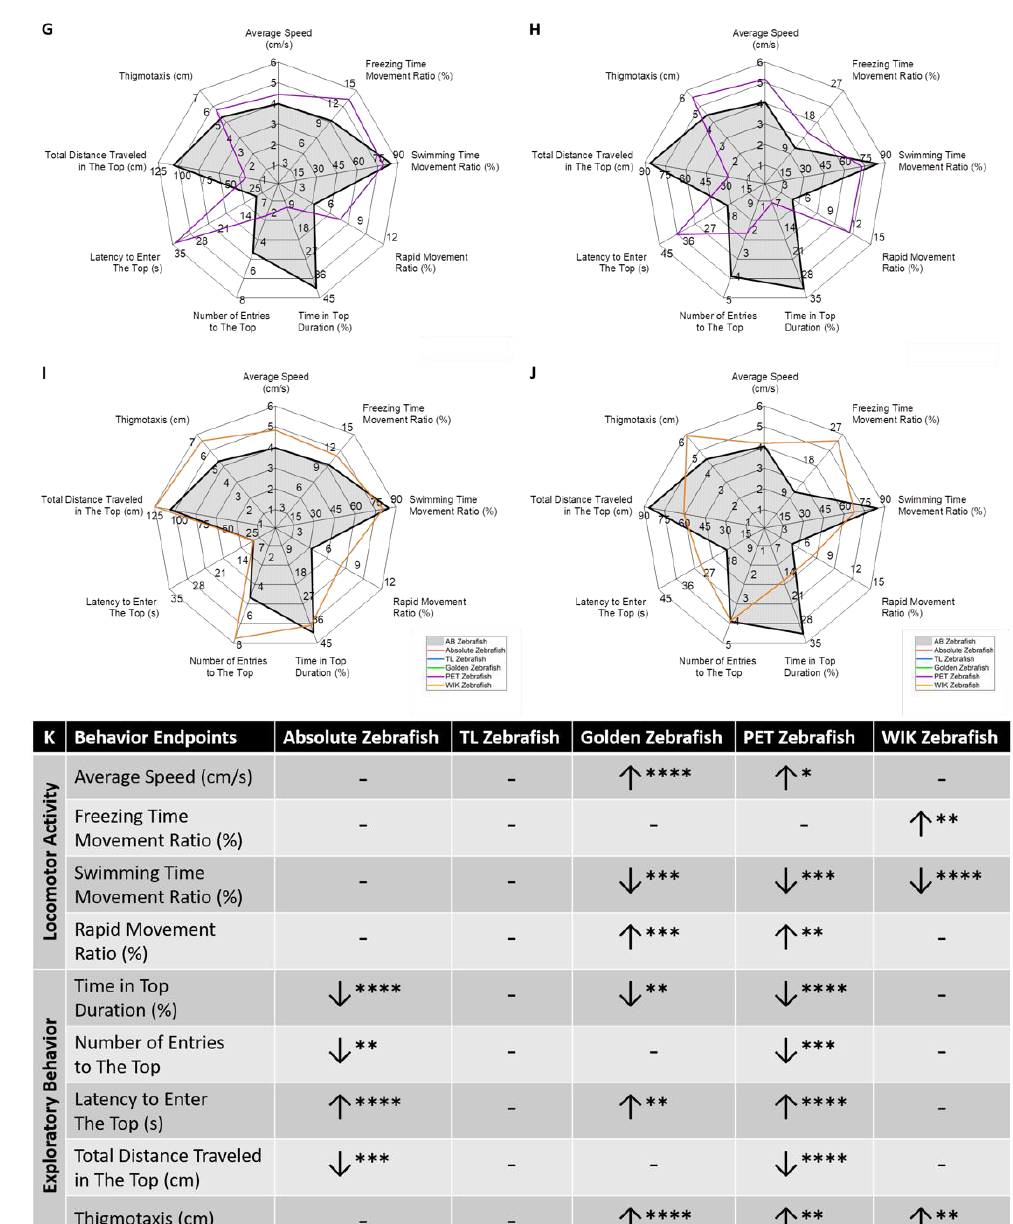
Figure 1. Behavioral response profile plots of AB zebrafish (black) compared to the ( A , B ) absolute mutant zebrafish (red), ( C , D ) Tübingen long fin (TL) zebrafish (blue), ( E , F ) golden zebrafish (green), ( G , H ) pet store-purchased (PET) zebrafish (purple), and ( I , J ) Wild Indian Karyotype (WIK) zebrafish (orange) before and after 11 min of exposure of a new environment in the novel tank test, respectively. The plots are expressed as the mean and all of the fish swimming activities during a 31 min test with a 1 min video with a time interval every 5 min were summarized and analyzed using two-way ANOVA with the Geisser–Greenhouse correction. ( K ) Summary table of the behavioral differences of several strains of zebrafish compared to the AB strain zebrafish. ↑ represents a significant increase in the value and ↓ indicates a significant decrease in the value in comparison to the AB strain zebrafish group, respectively, while “-” represents a non-statistically different in the value in comparison to the AB strain zebrafish group ( n = 30 for each group, except for the WIK zebrafish ( n = 23); * p < 0.05; ** p < 0.01; *** p < 0.001; **** p <